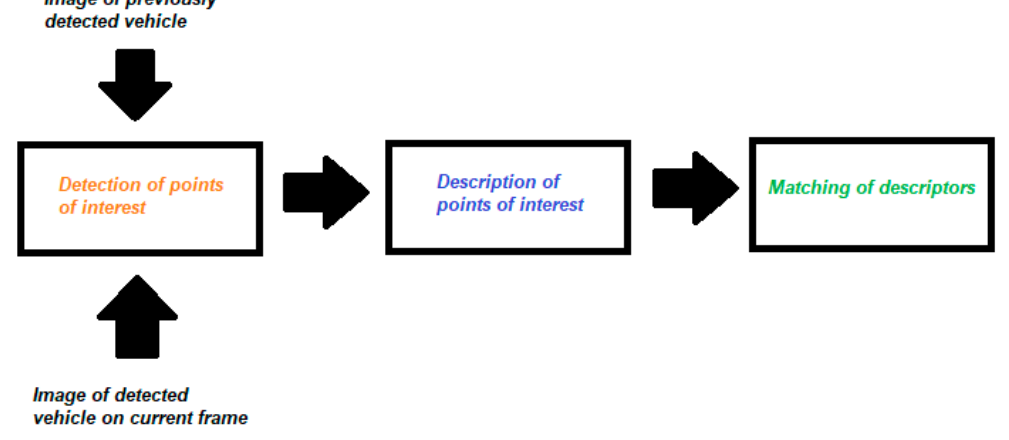
Figure 10. Steps of the SURF algorithm.